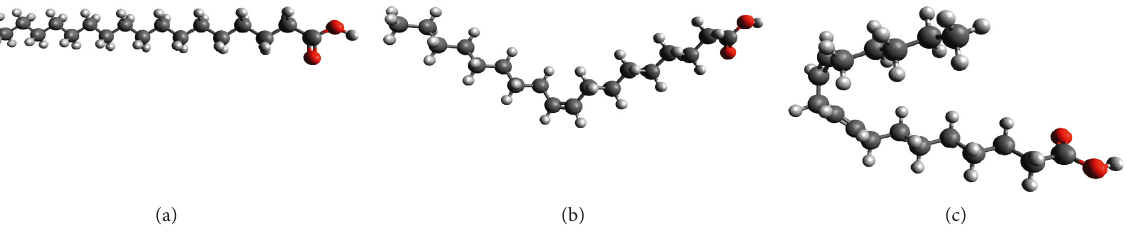
H O (a); C18:1, oleic acid C 18 36 2